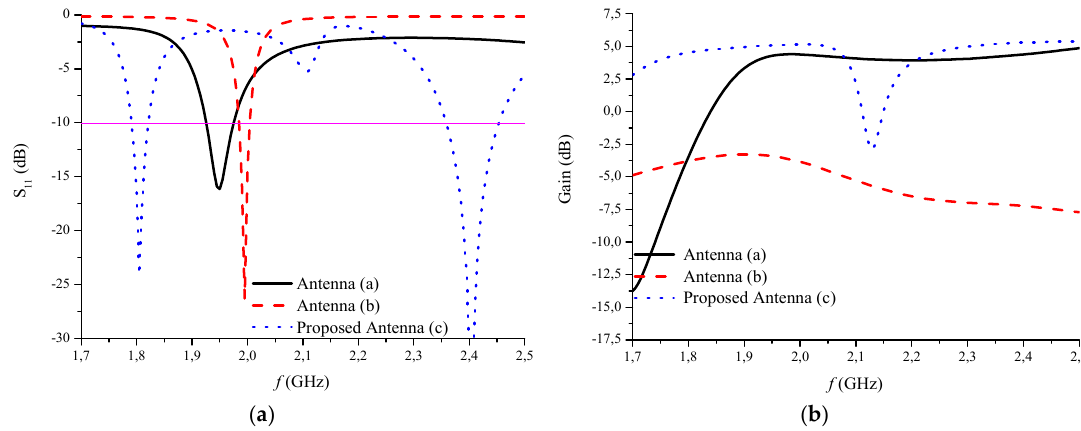
Figure 5. ( a ) Simulated S 11 of the three antennas depicted in Figure 4; ( b ) Simulated gain of the three antennas depicted in Figure 4.